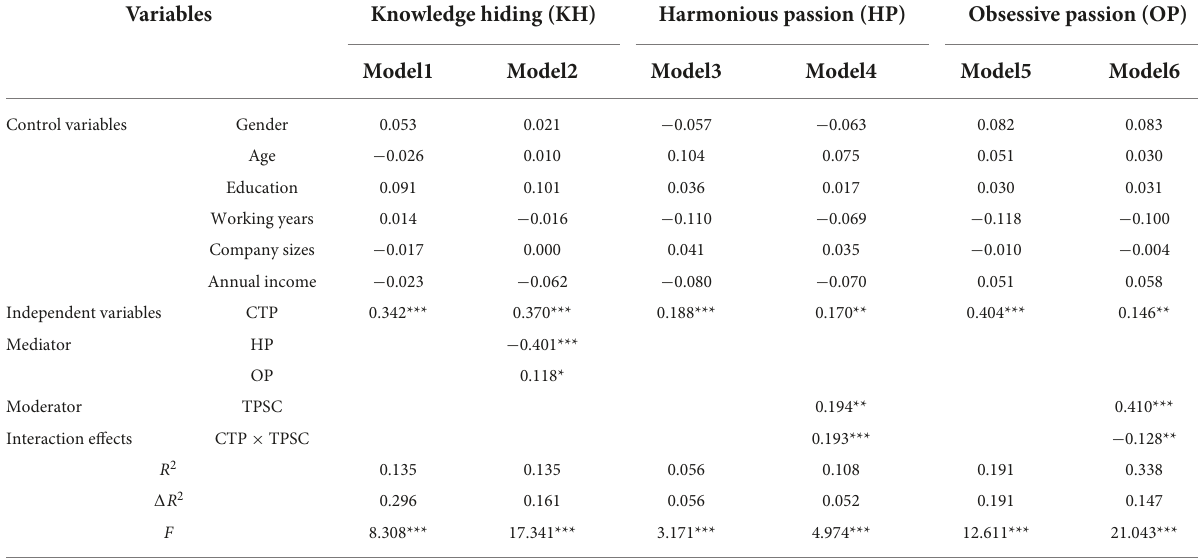
TABLE 4 Results of hierarchical regression analysis of mediation and moderation